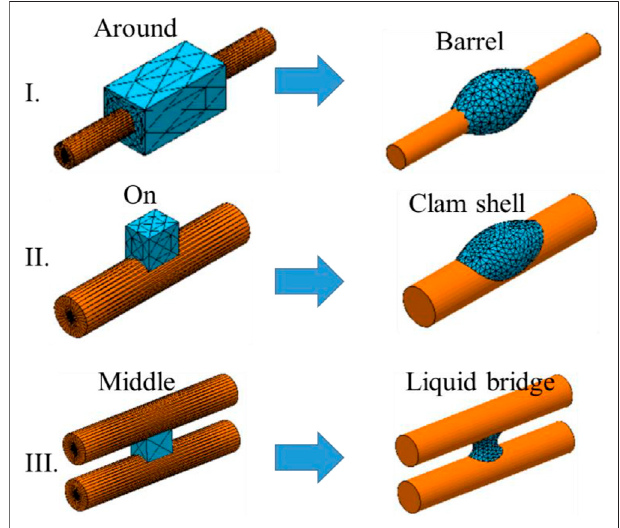
FIGURE1| Theinitialshapeofdifferentconformations.I.Barrelshape,II. clam shell shape, III. liquid bridge